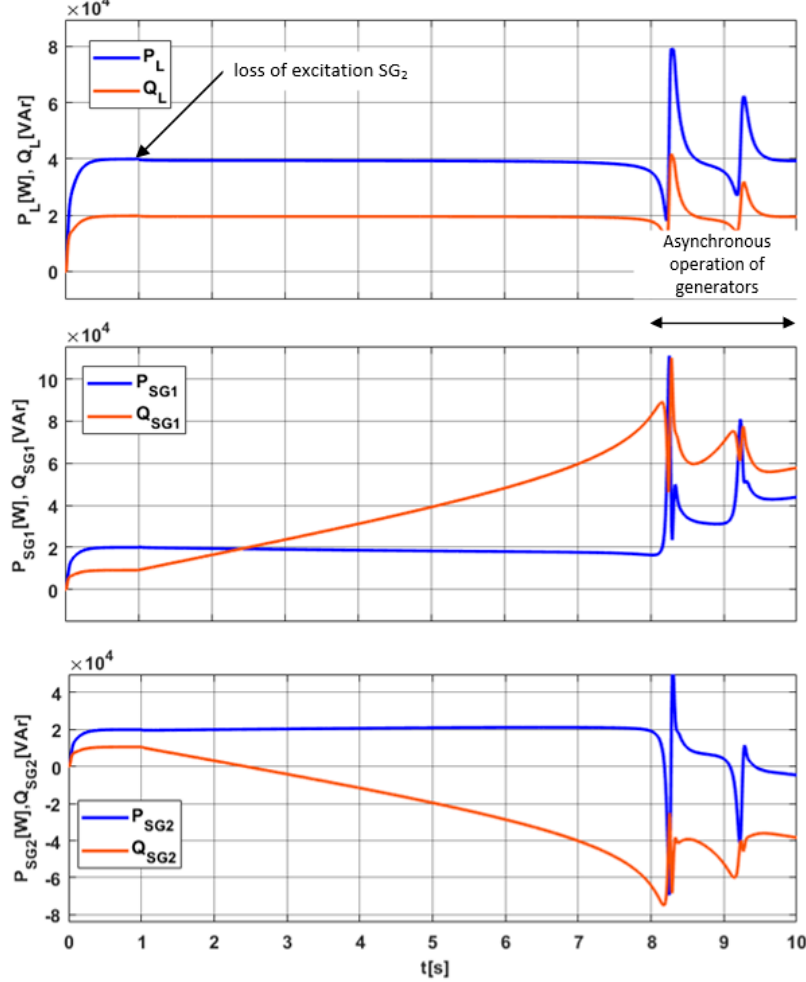
Figure 12. Energy characteristics of the active and reactive power of the load ( P L , Q L ), as well as the active and reactive power for SG 1 ( P SG1 , Q SG1 ) and SG 2 ( P SG2 , Q SG2 ).